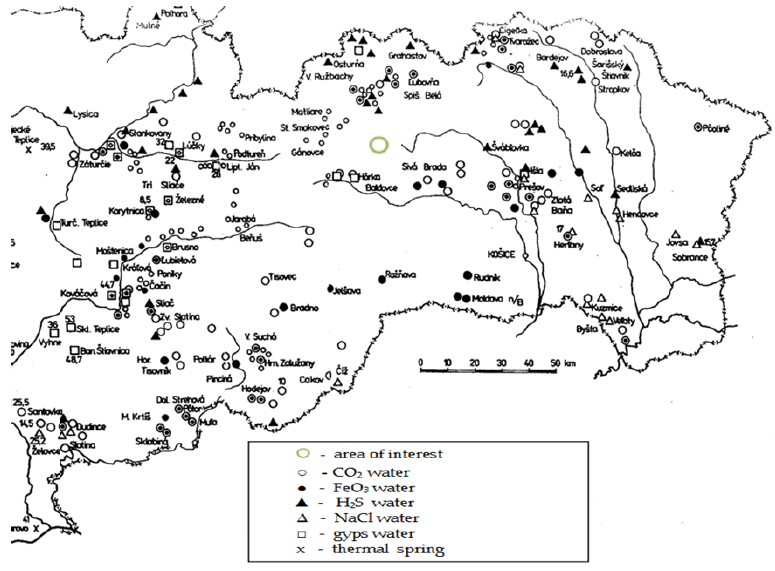
Figure 2. Partial map of geothermal wells in